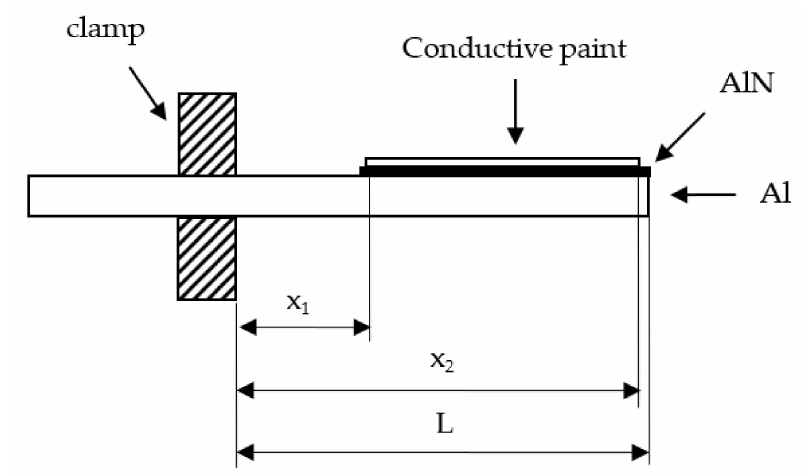
Figure 1. Schematic view (partial and out of scale) of the cantilever beam with piezoceramic layer test